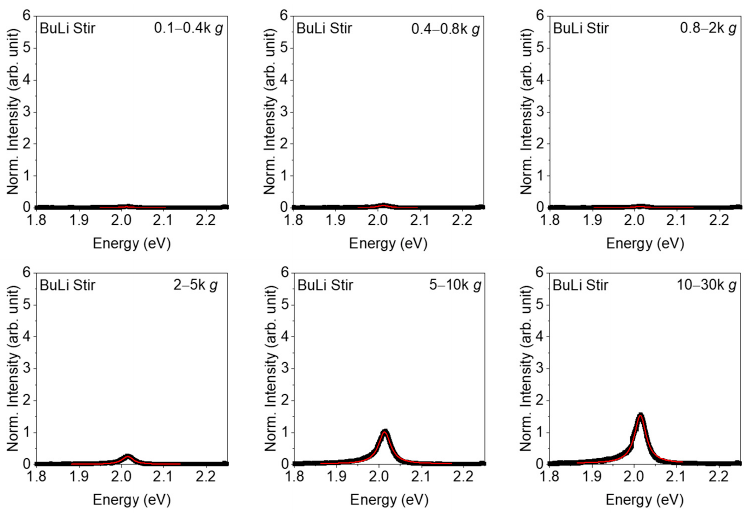
Figure A7. Photoluminescence spectra ( λ exc = 532 nm) the WS 2 nanosheet dispersions, exfoliated by tip sonication with a 30% amplitude. The bulk starting material was stirred in NMP prior to exfoli ‐ ation. The PL was fitted by Lorentzians for quantitative analysis. Spectra of fractions which were collected during liquid cascade centrifugation but did not show any PL are excluded.